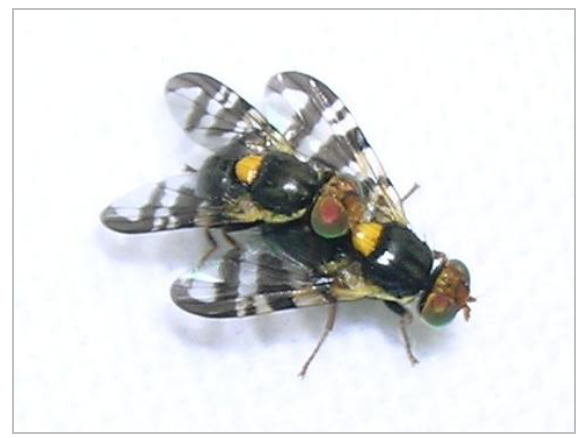
Figure 2. Mating of R. cerasi